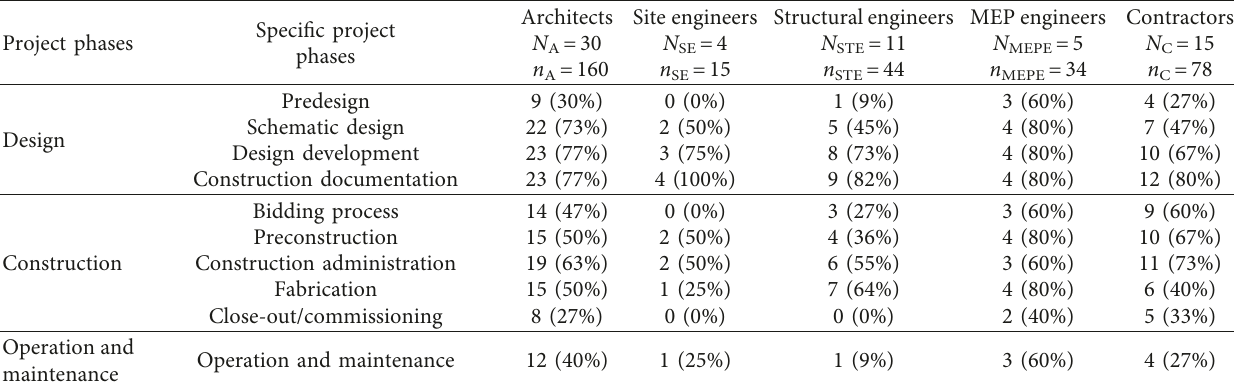
Table 9: Relationship between the role of the respondent and the perceived value of BIM in different phases of the design and construction process ∗